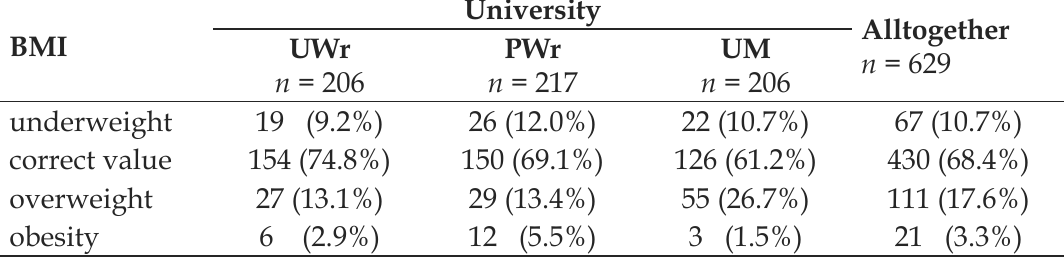
Body mass index - BMI at each